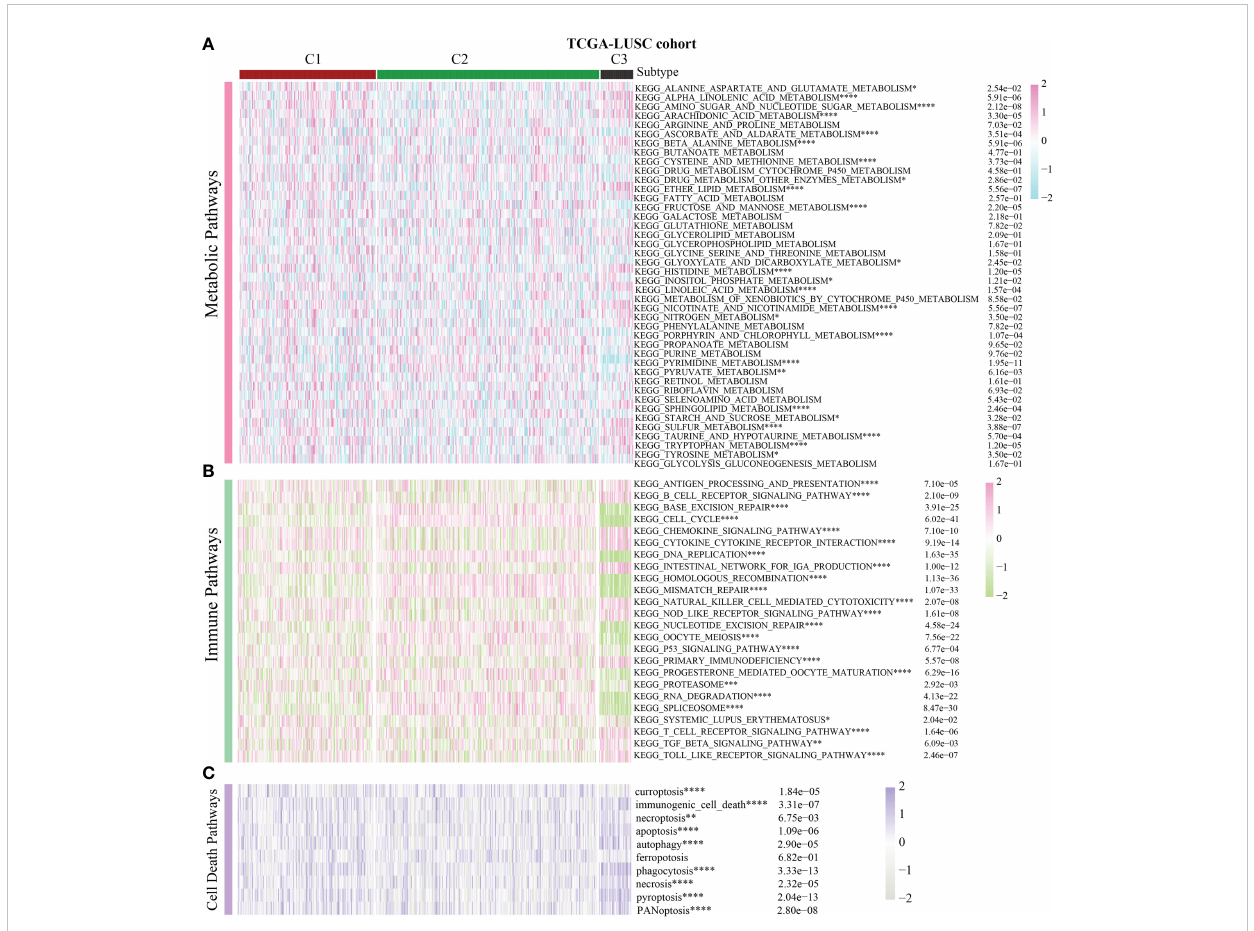
FIGURE 6 Correlation of the cell cycle-related gene scores with metabolic reprogramming, immunological microenvironment, and cell death pathways in LUSC. (A) Activity of well-recognized metabolic reprogramming in the three clusters for LUSC. (B) Activity of well-recognized immune pathways in the three clusters for LUSC. (C) Correlation between the cell cycle-related gene scores and cell death pathways for LUSC. * indicates p < 0.05; ** indicates p < 0.01; *** indicates p < 0.001; and **** indicates p <